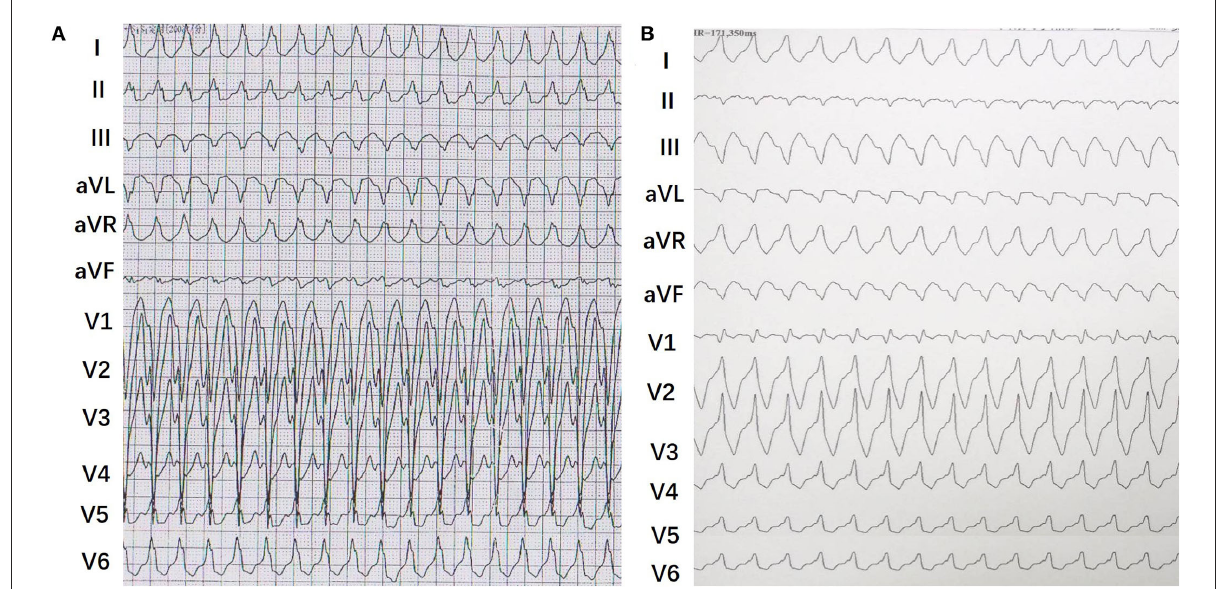
FIGURE1 Representative 12-leads surface electrocardiograms of tachycardia in patients with right-sided and left-sided Mahain-type accessory pathways (MAPs). (A) It showed a typical wide QRS complex tachycardia with a left bundle branch block (LBBB) pattern. (B) It showed a typical wide QRS complex tachycardia with a right bundle branch block (RBBB) pattern.